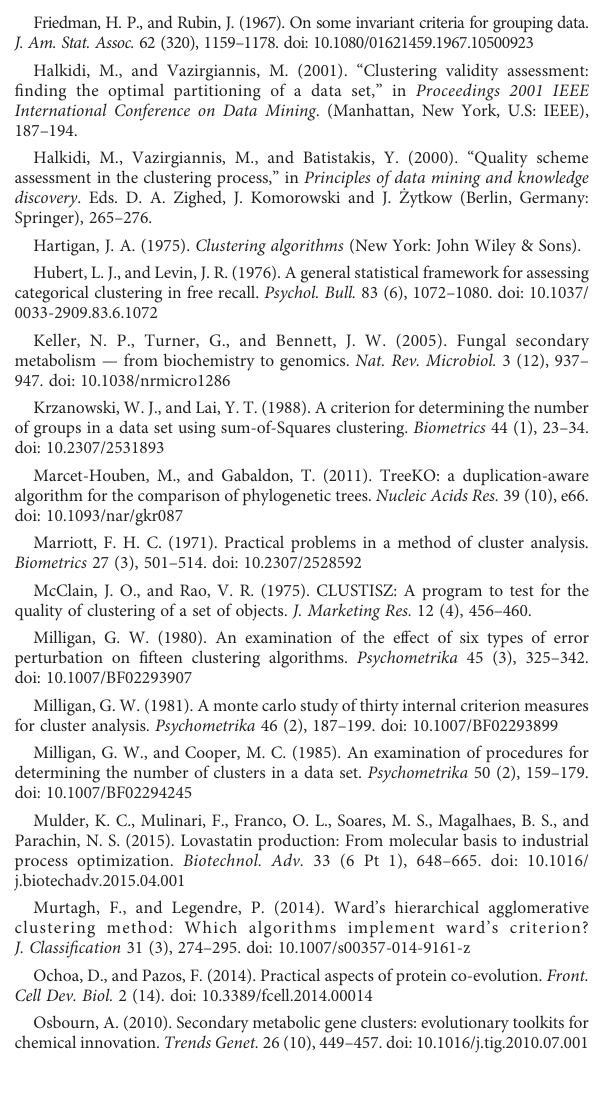
SUPPLEMENTARY TABLE 1 ICQ values of protein sets of conserved metabolic pathways of the primary metabolism (BioPath), sequential GCs, and random GCs used in this study.